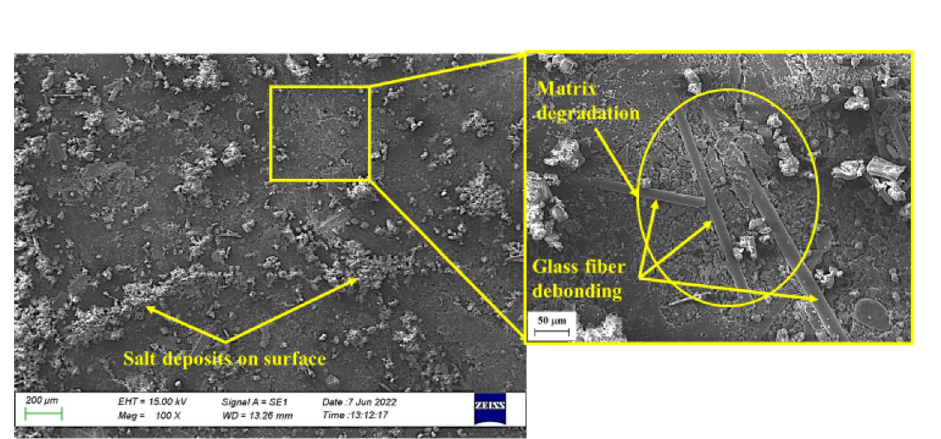
Figure 12. Scanning electron micrographs of the surface of the MCC0 composite post-immersion in